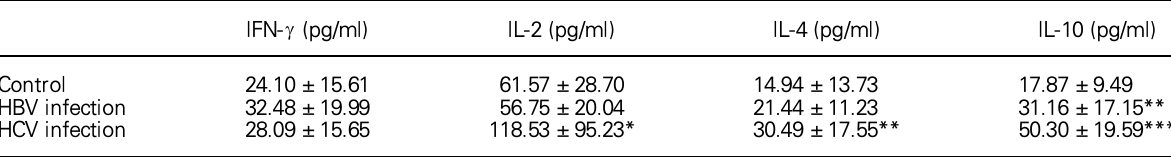
Table 2. The comparison of serum cytokines in three studied